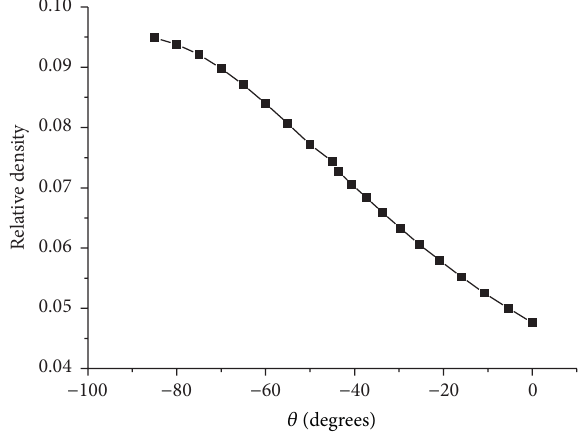
Figure 6: 𝜌/𝜌 𝑠 versus 𝜃 calculated from (1) for equal-height cells, where ℎ/𝑙 = 2 , 2𝑙 cos 𝜃 = 42.86 mm, and 𝑡 = 1